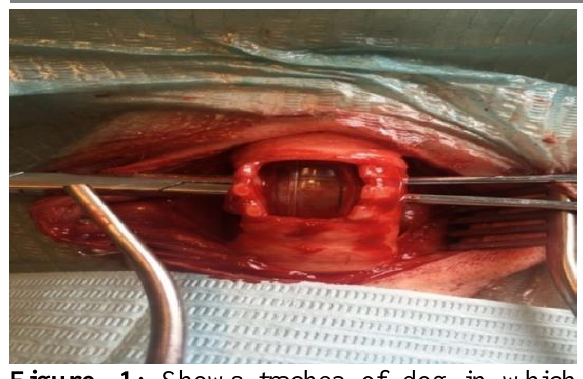
Figure, 1: Shows trachea of dog in which 2x3cm tracheal defect were created.